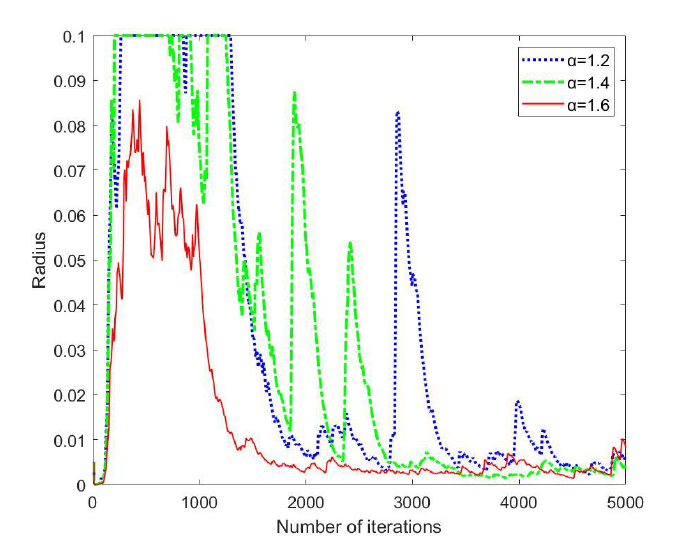
Figure 7. Adjustment of the adaptive radius.